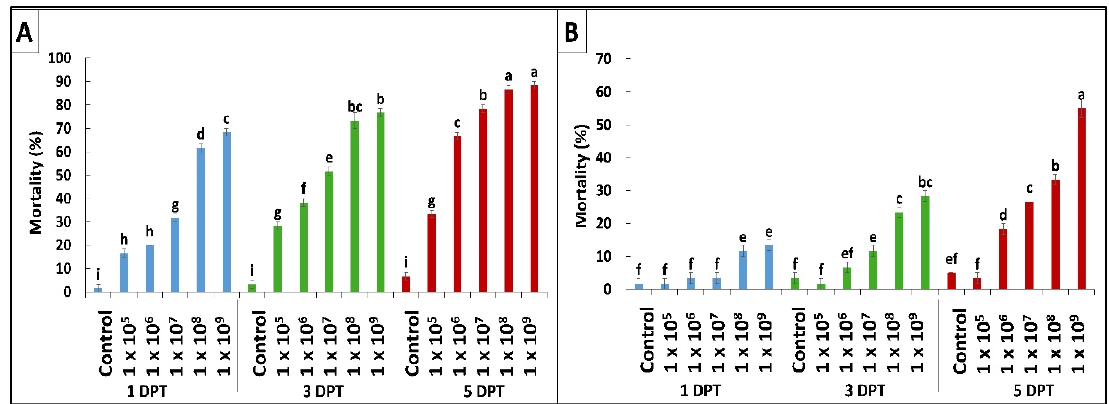
Figure 1. Mortality (%) of O. furnacalis larvae fed on B. bassiana OFDH1-5 ( A ) and T. asperellum GDFS1009 ( B ) incorporated diet at the first, third, and fifth day post treatment (DPT). Means followed by different lowercase letters above each bar indicates significant differences among the treatments (p < 0.05 ).